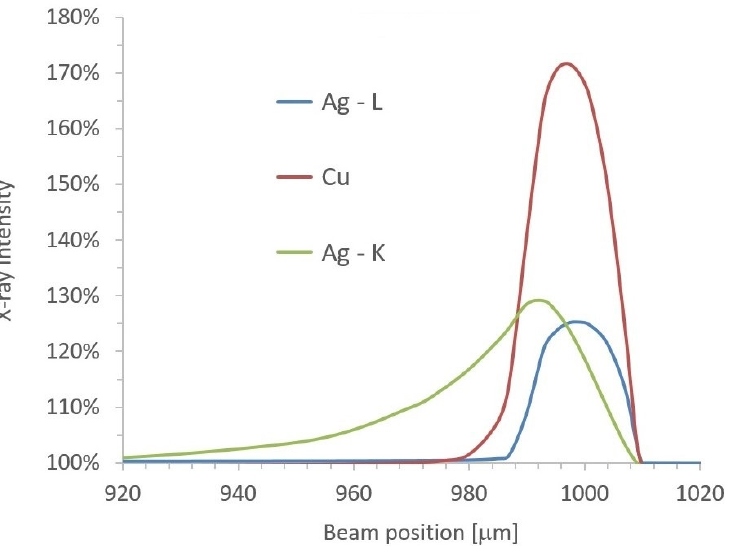
Figure 12. Relative X-ray intensities of copper and silver close to sharp edge on the right (x = 1 mm).